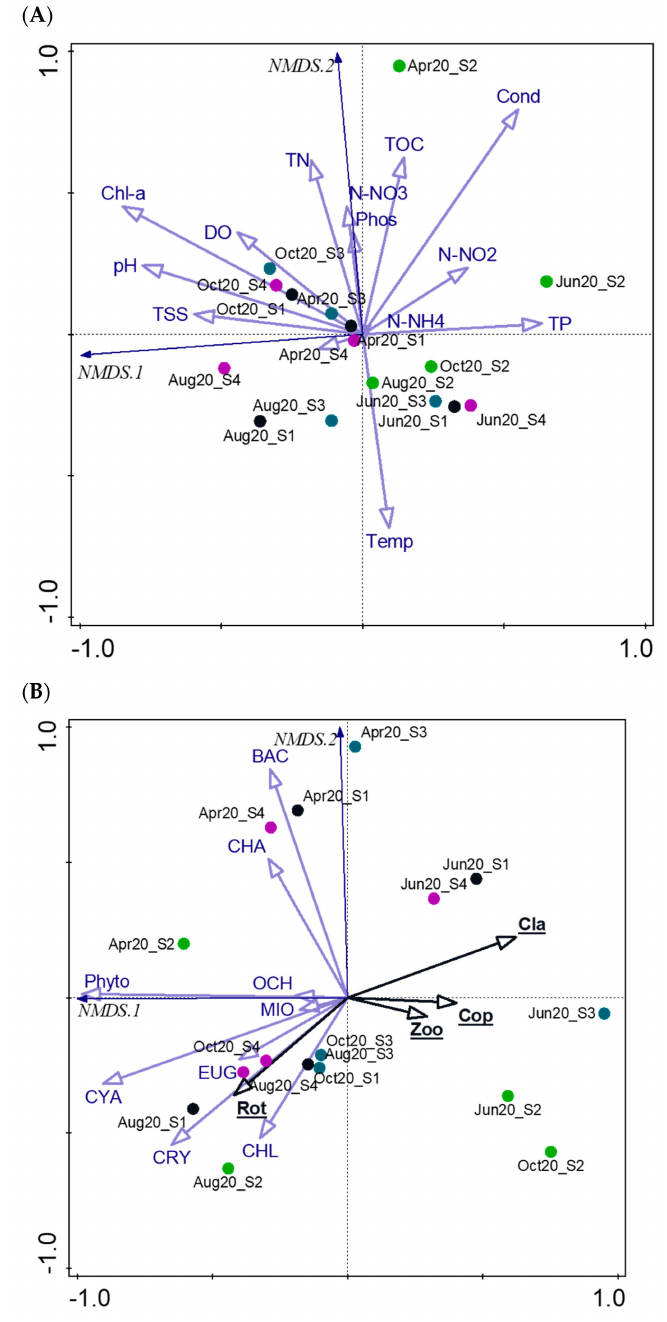
Figure 7. The non-metric multidimensional scaling (NMDS) plots based on environmental parame- ters ( A ) and phytoplankton and zooplankton ( B ). Codes: Temp—water temperature; DO—dissolved